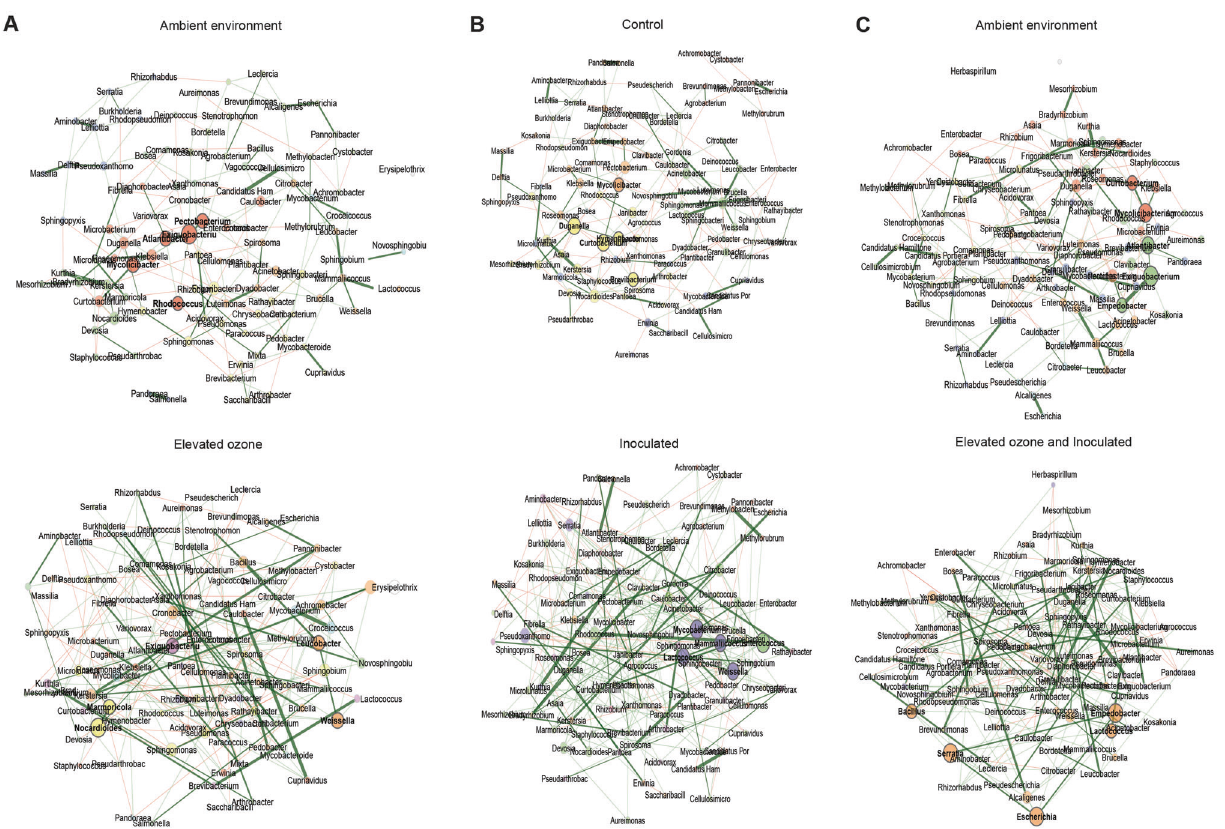
Fig. 6 Pathogen infection is associated with microbial communities showing positive and stable interactions, but these interactions are random and less predictable with a shift in hub taxa in response to concurrent O 3 stress and pathogen infection. Comparison of bacterial association network across different environments. A Bacterial association network for the combined data set of ambient (top) and elevated O 3 (bottom) in both cultivars under control conditions. B Bacterial association network for the combined data set from control (top) and inoculated (bottom) samples from both the cultivars under ambient environment. C Bacterial association network for the combined data set from control and ambient environment (top) and inoculated and elevated O 3 (bottom) samples from both cultivars. Hub taxa are highlighted by bold text. Node color represents the cluster determined by greedy modularity optimization. Red edges correspond to negative correlations, while green edges correspond to positive difference in hub taxa among treatment groups when comparing control with inoculated samples or control and ambient environ- ment with pathogen and O 3 stress (Table S11A, B). However, there was no change in hub taxa on plants exposed to elevated O 3 compared to ambient environment. Comparing the overall similarities of the two networks between the ambient vs. individual stress or combined stress of elevated O 3 and pathogen based on adjusted Rand index (ARI) indicated values close to 0 (ARI = 0.02, p = 0.07) for ambient vs. elevated O 3 stress; control vs. inoculated (ARI = 0.03, p = 0.02) and control and (Table S11C). These observations indicate that the partitions of species into communities show a low degree of similarity in these comparisons. These results, with differences in topology between these networks and dissimilarity in local network centrality measures, indicate that combination of pathogen infection and O